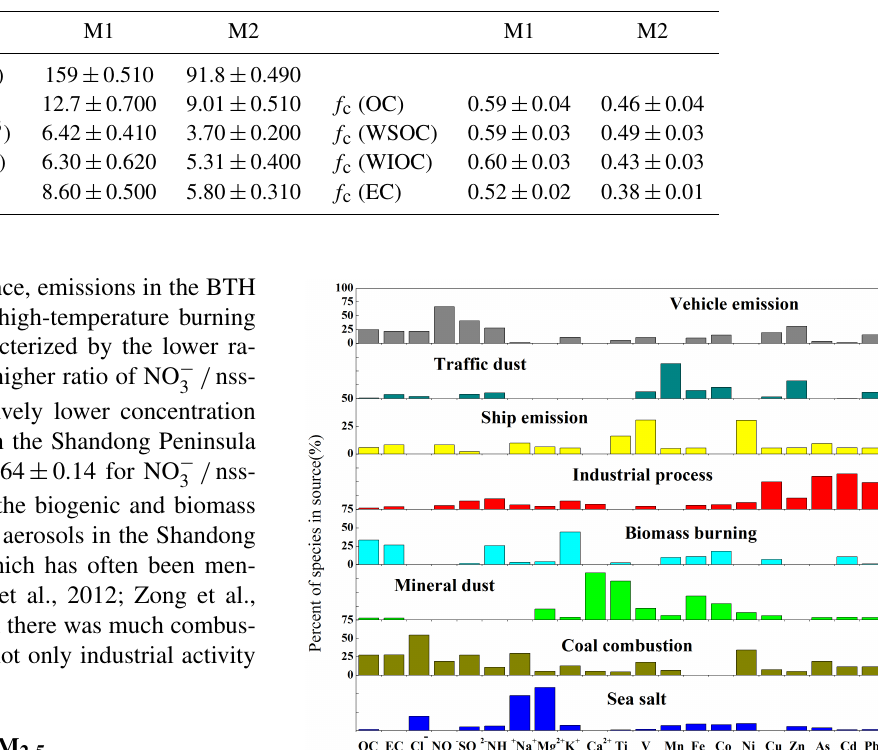
Table 2. Concentration and contemporary carbon fraction of carbonaceous species in M1 and M2.